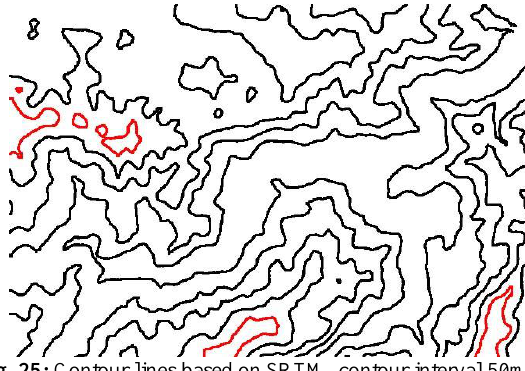
Fig. 25: Contour lines based on SRTM, contour interval 50m The shown contour lines of a small sub-area, of approximately 6km x 5km, based on LiDAR (Fig. 21) are using a reduced LiDAR grid of 10m point spacing. It is nearly identical to the contour lines based on WorldDEM (Fig. 22), having also 10m point spacing. The accuracy of the LiDAR heights, estimated with 20cm, is clearly better as for WorldDEM, determined with NMAD=1.03m, but for the shown scale and the contour interval of 50m the lines are nearly